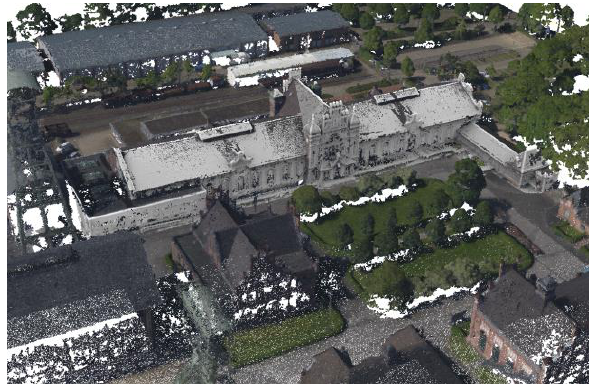
Figure 6. Coloured point cloud from software PhotoScan with overlaid TLS point cloud “Lohnhalle” in grey